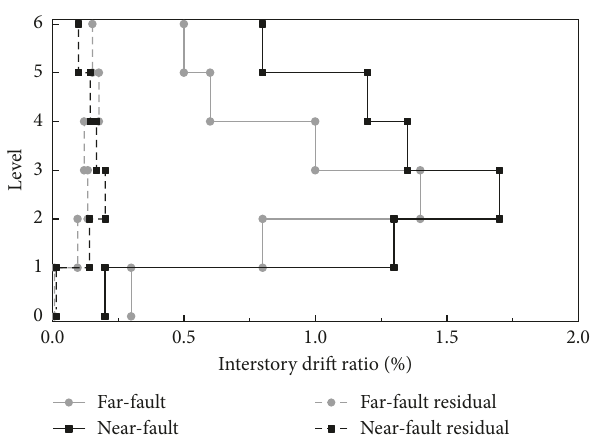
Figure 5: Interstory and residual drift ratio along the building